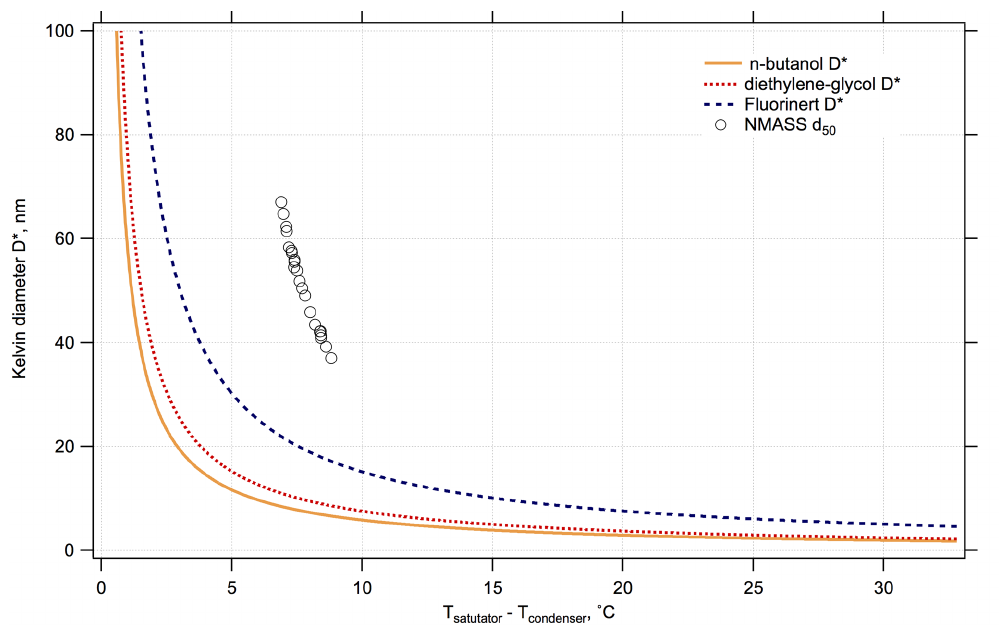
Figure 3. Kelvin diameter D ∗ , or critical diameter, as a function of difference in temperature between saturator and condenser, for n -butanol (used in many commercial CPCs such as the TSI-3776, Hermann et al., 2007), diethylene glycol (used in commercial and custom-built two- stage CPCs such as the Airmodus Particle Size Magnifier, Vanhanen et al., 2011; Iida et al., 2009) and Fluorinert FC-43 (used in the NMASS CPCs). The saturator temperature is 34.8 ◦ C. For a given D ∗ the slope of the curve for FC-43 is less than for n -butanol or diethylene glycol. The measured diameter of 50% detection efficiency, d 50 , for an NMASS CPC is also shown as a function of temperature, as discussed in Sect. 3.2. The NMASS CPC d 50 s are larger than the theoretical Kelvin diameter for Fluorinert because heat and mass transfer within the condenser limits the supersaturation achieved to values less than the theoretical maximum. The range of d 50 s shown here, around 40–60nm, are on the steep part of the diameter curve. This limits the largest d 50 that can be achieved with the NMASS because, in this region, a small variation in temperature difference causes a large variation in d 50 , making the detection efficiency